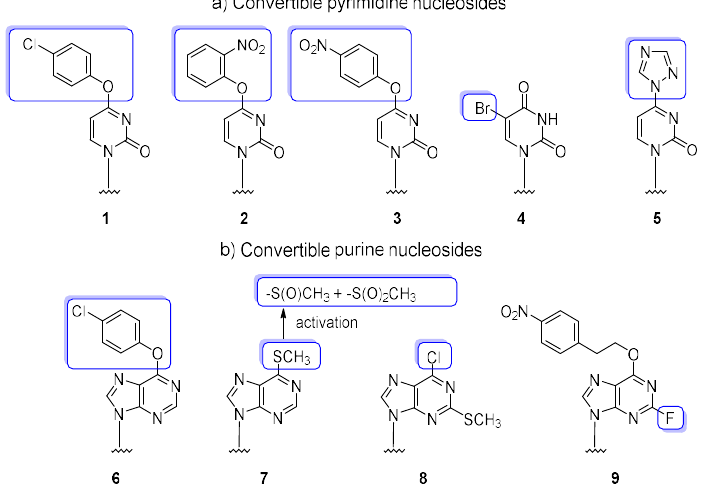
Figure 4. Convertible nucleosides employed in the post-synthetic transformations of precursor RNA via nucleophilic aromatic substitution. The leaving groups are indicated in the frames.